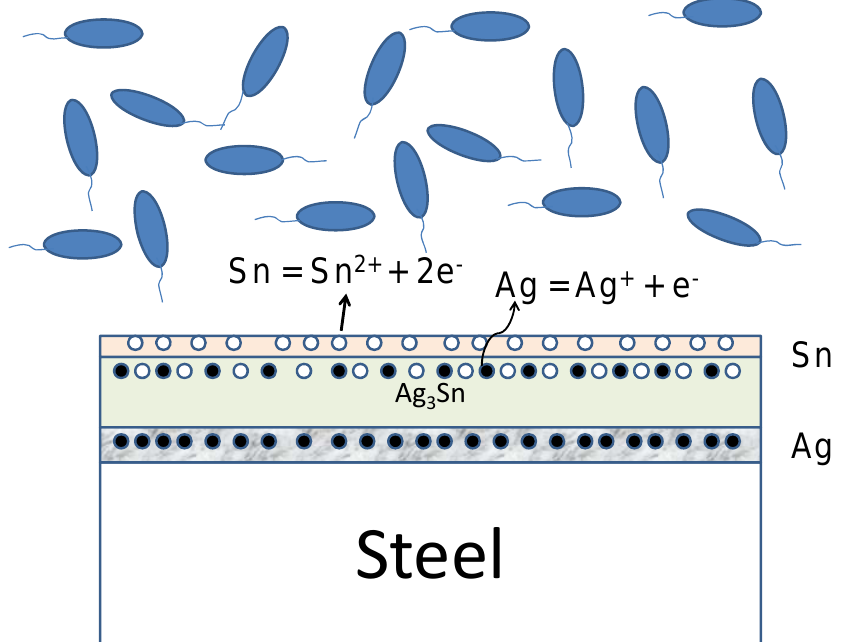
Figure 4. Schematic illustration of the surface structure for Sn-Ag alloy film produced by heat